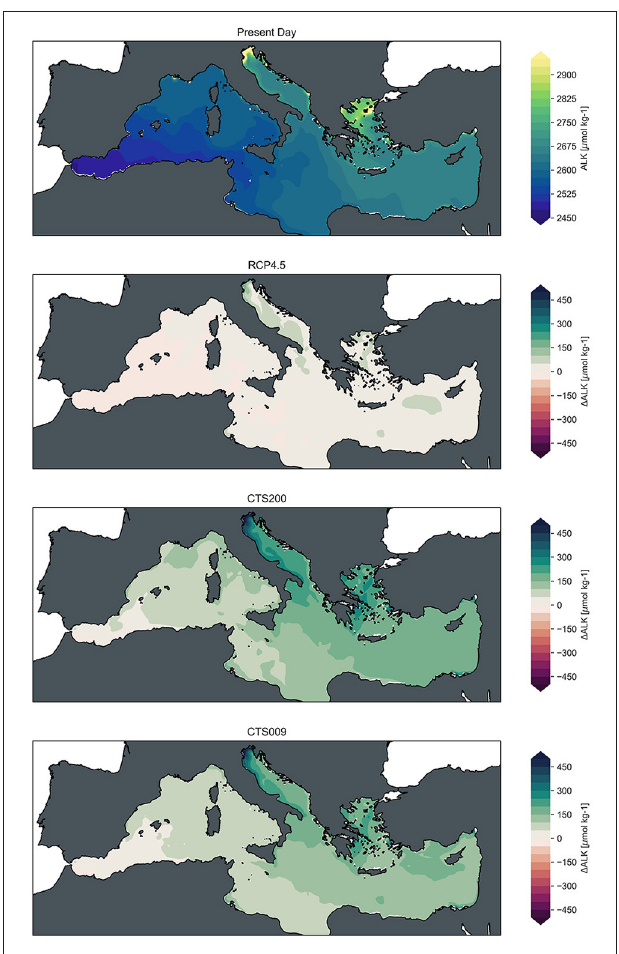
FIGURE 4 | Fields of mean surface alkalinity [ µ mol kg − 1 ] for present day (2016–2020) and changes of mean fields at mid-century (2046–2050) with respect to present day conditions for RCP4.5 baseline scenario, CTS200 scenario and CTS009 scenario (from top to bottom).